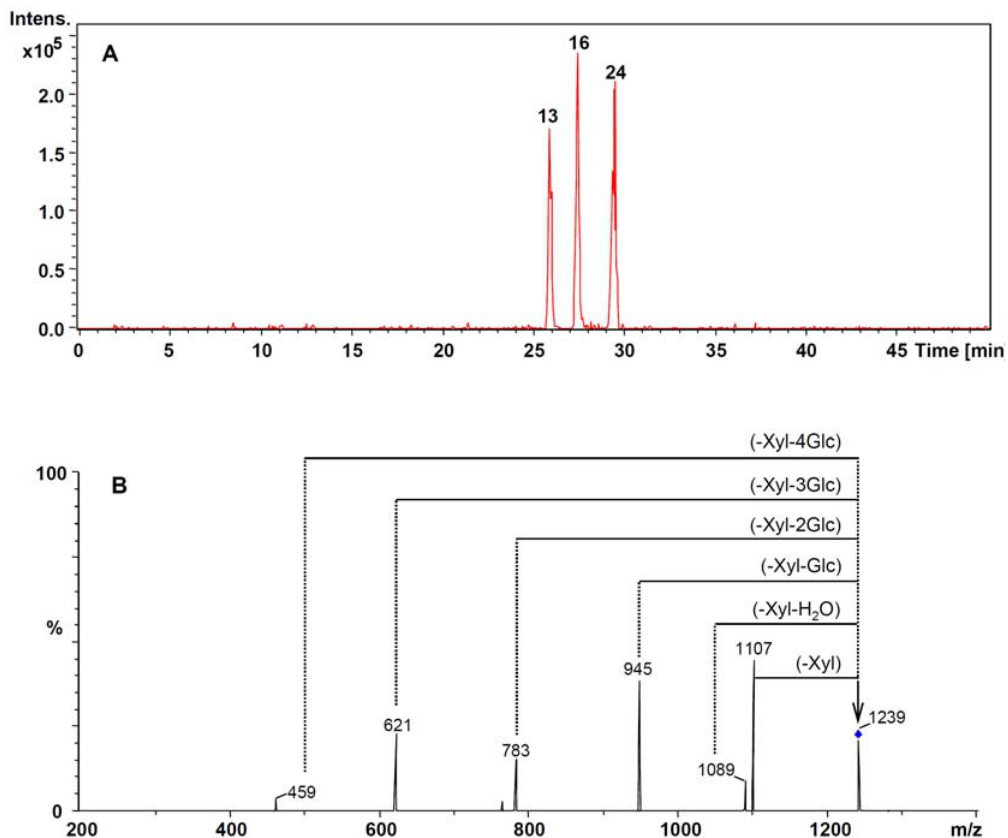
Figure 6. The extracted ion chromatogram of m/z 1,239 ( A ) and the CID spectra of parent ion [M − H] − with m/z 1,239 ( B ) The mass-charge ratio of mass-selected ion is indicated by a vertical